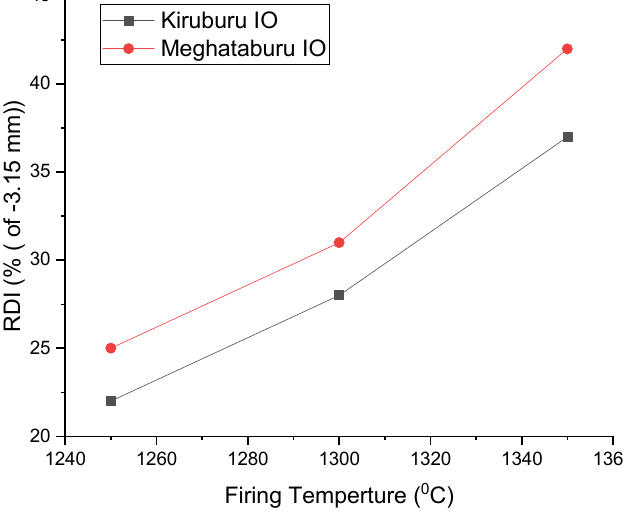
Figure 17. Effect of Firing Temp. on R.D.I.